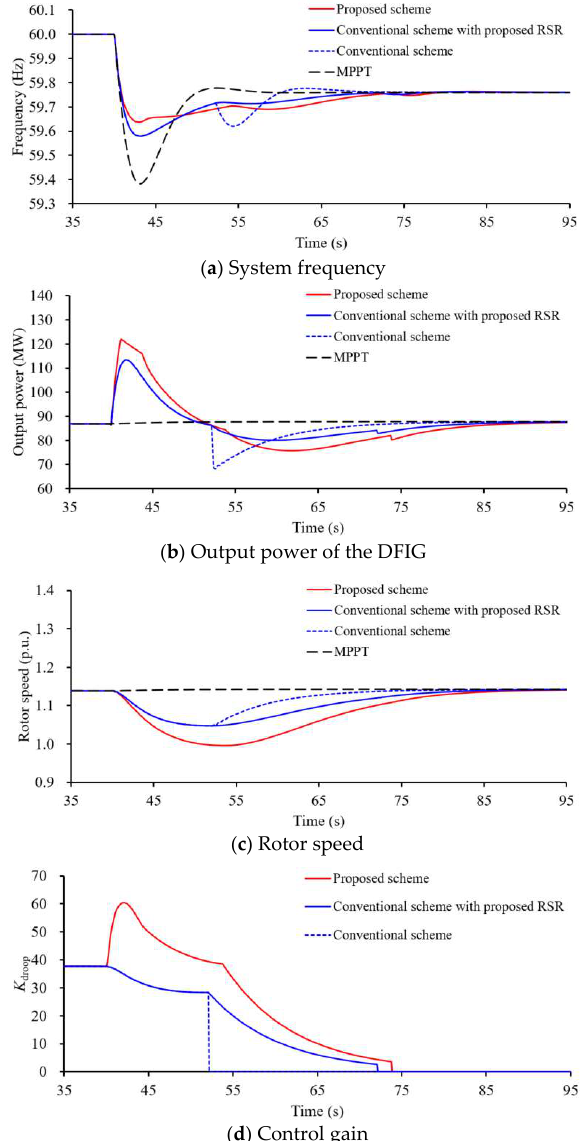
Figure 13. Results for Case